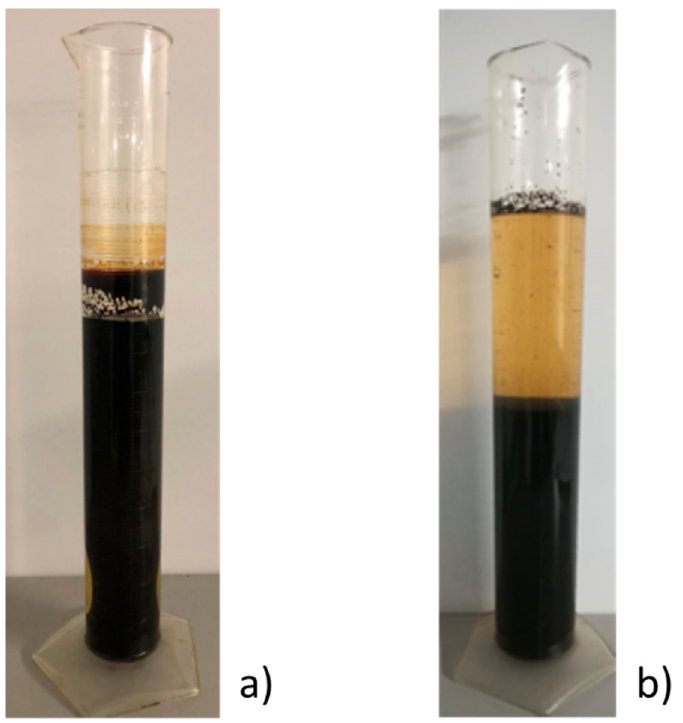
Figure 3. Pictorial representation of Adriatica bitumen emulsions obtained with aliphatic/aromatic acid surfactant (AS) additive ( a ), and without AS additive ( b ).